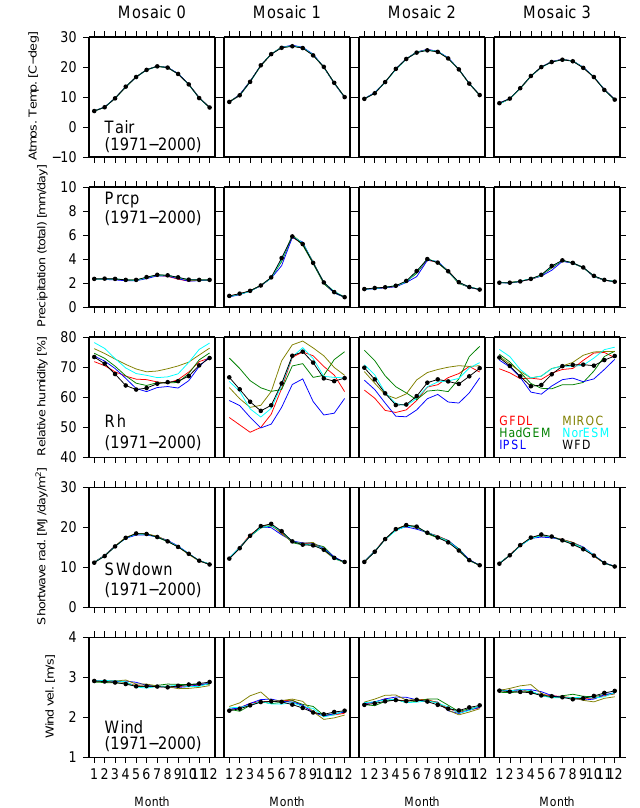
Figure 2. Monthly profiles of meteorological elements used in this study for 1971–2000. The results are aggregated over each type of land use, identified by the mosaic number. Profiles of the five GCMs are indicated in different colors: (red) GFDL, (green) HadGEM, (blue) IPSL, (dark yellow) MIROC and (light blue) NorESM. Pro- files of the WATCH data are shown as black lines with